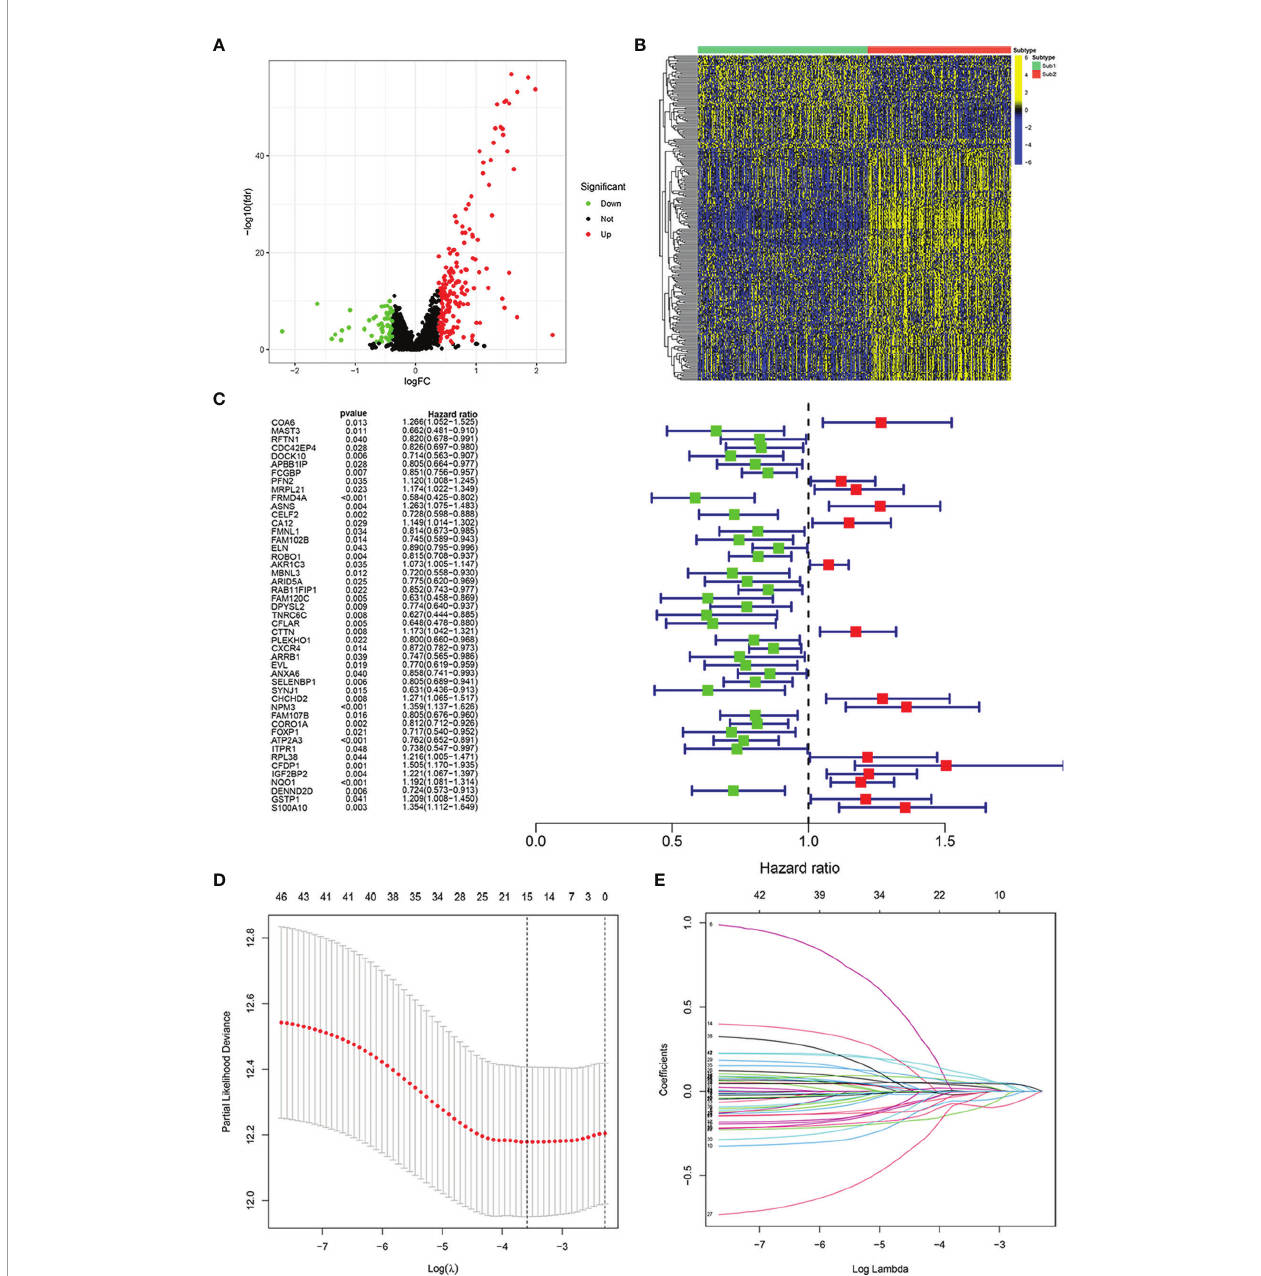
FIGURE 3 | Construction of risk model for prognosis in patients with head and neck squamous cell carcinoma (HNSCC). Volcano plot exhibiting the differentially expressed immune-related RNA-binding proteins (RBPs) between Sub1 group (n = 271) and Sub2 group (n = 228) in HNSCC (A) . Heatmap of differentially expressed immune-related RBPs in Sub1 and Sub2 groups (B) . The result of univariate Cox analysis (C) and least absolute shrinkage and selection operator (LASSO) Cox analysis (D, E)